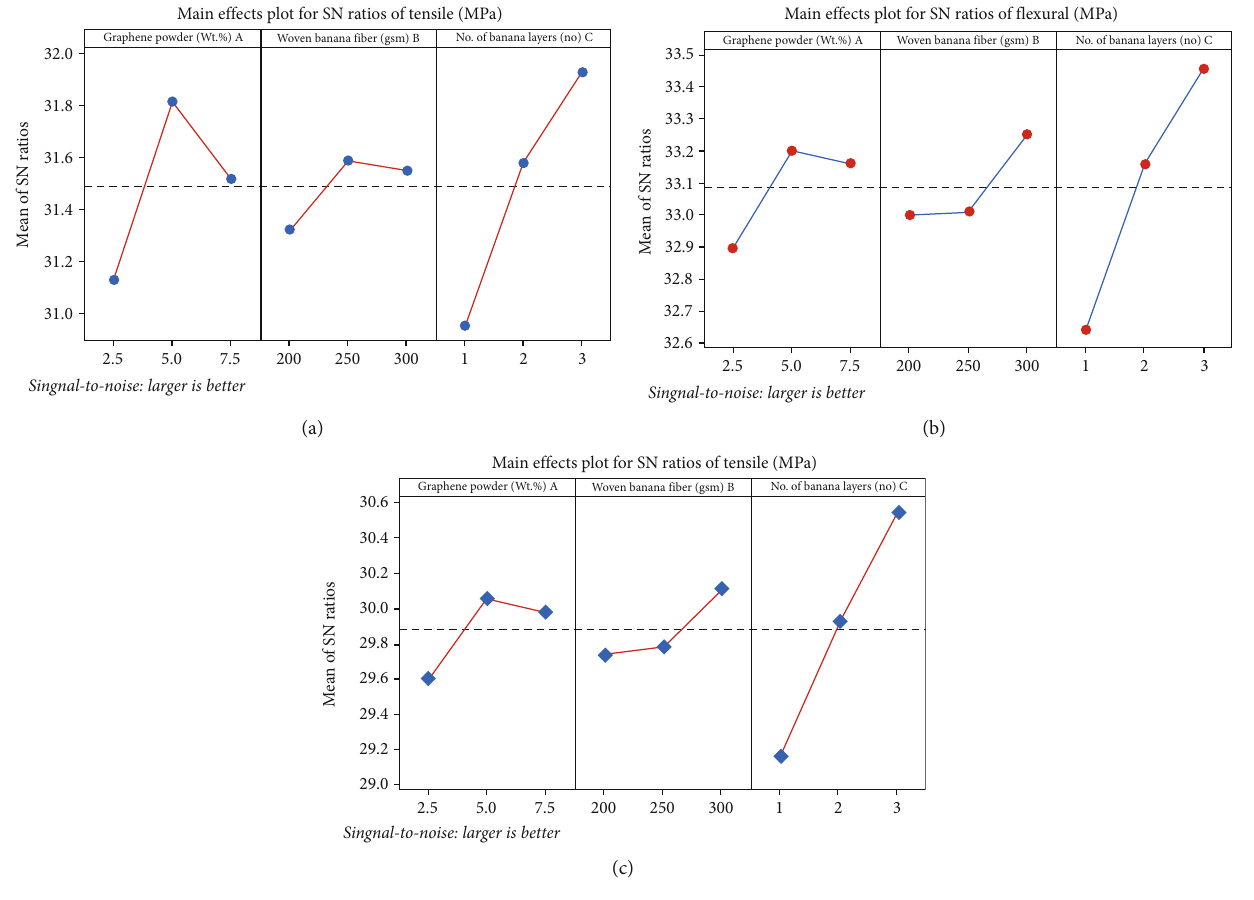
Figure 3: S/N values of mechanical properties: (a) tension; (b) bending, and (c) impact. Table 4: S/N and standardized S/N